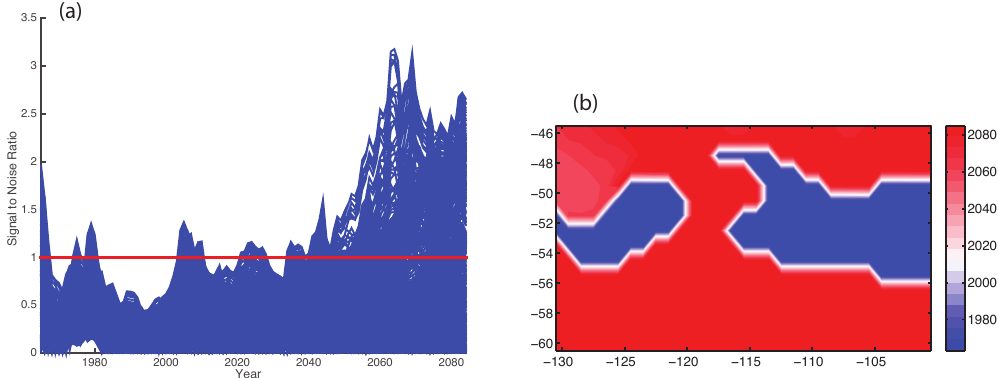
Figure A3. Time of emergence of SST considered for a boxed region of the Pacific sector of the Southern Ocean (130–100 ◦ W and 45–60 ◦ S). The SNR calculated individually using annual mean SST for each gridpoint in the domain is shown in panel (a) , where a 30-year window is used to calculated TREND and NOISE. Short timescale excursions of less than 10 years are in evidence in modulations of maximum SNR. The spatial pattern of ToE for SST over this region is shown in panel (b) . A ToE before the present time (pre-2014) is indicated by shades of blue, while a later ToE is indicated with shades of red. Saturation (ToE post-2085) is represented with a deep red color.